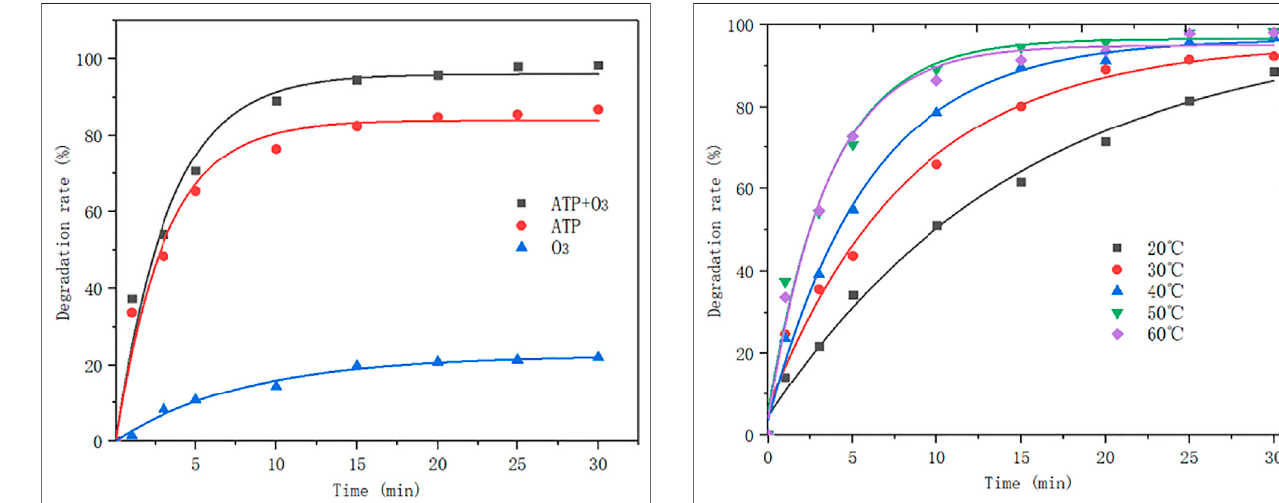
FIGURE 5 | Comparative experimental results of ozone and catalyst.